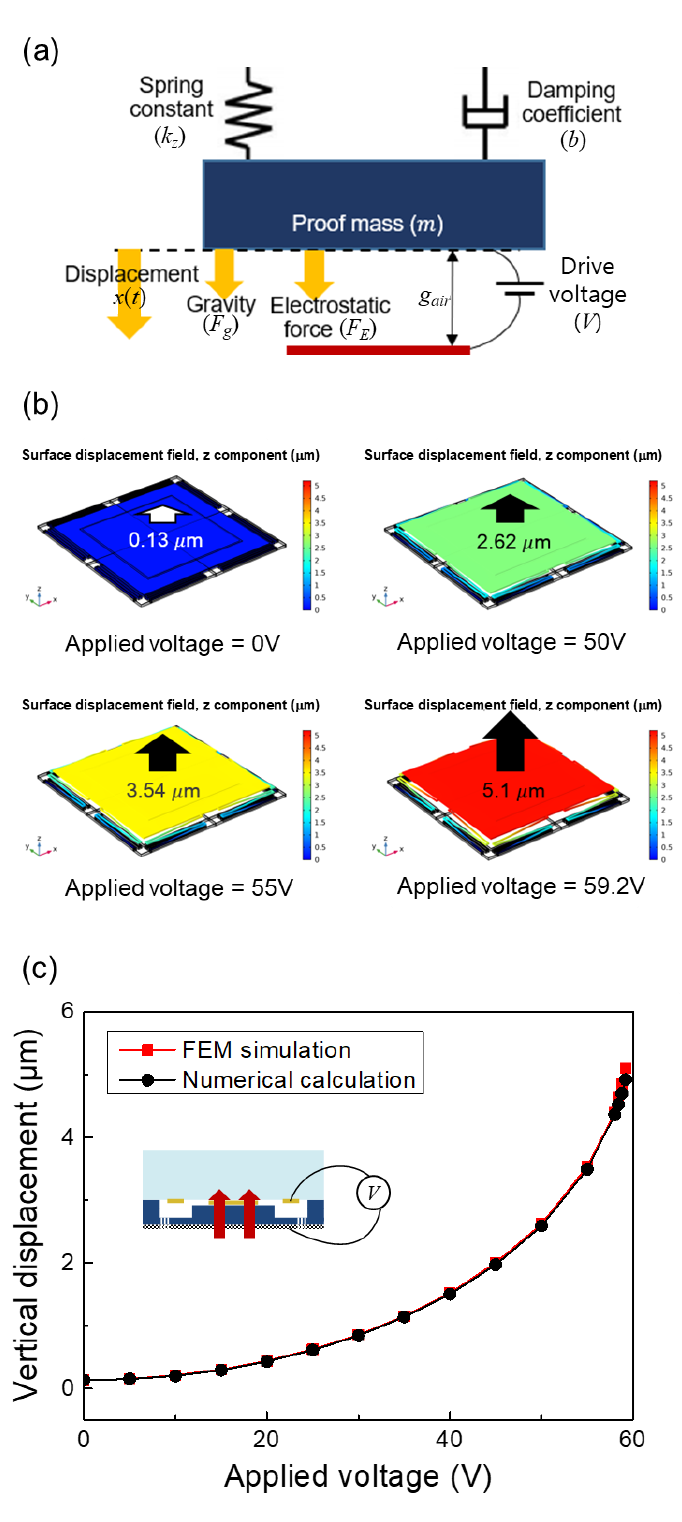
Figure 4. ( a ) Vertical MEMS actuator schematic expressed by spring-mass-damper system, ( b ) sim- ulation results of electrostatic-driven behavior, ( c ) comparison of displacement obtained by the FEM simulation and the numerical